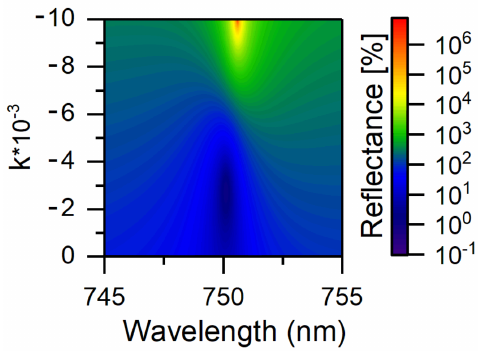
Figure 5. Reflectance spectra of the structure at negative values of the imaginary part k of the CLC refractive index. In contrast to passive structures, the reflectance goes beyond unity, as it is not limited by the energy conservation law. The sharp growth of the reflectivity at k < − 0.009 indicates the lasing threshold